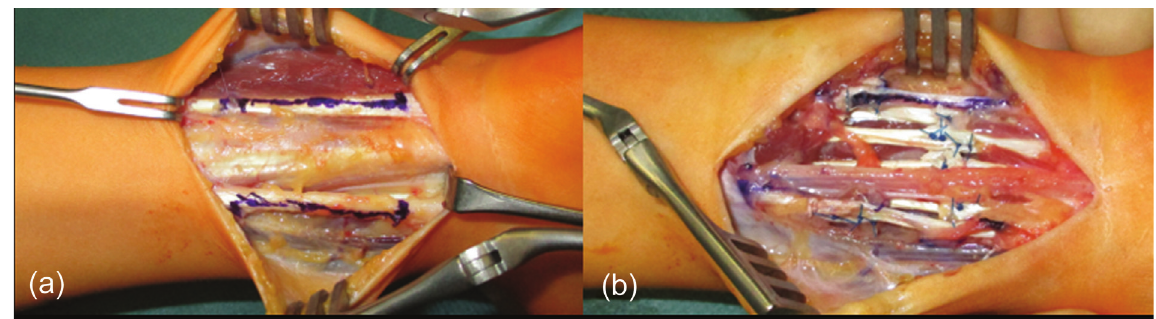
Fig. 2 Steps of the surgical procedure after neurolysis and stepwise tenolysis and